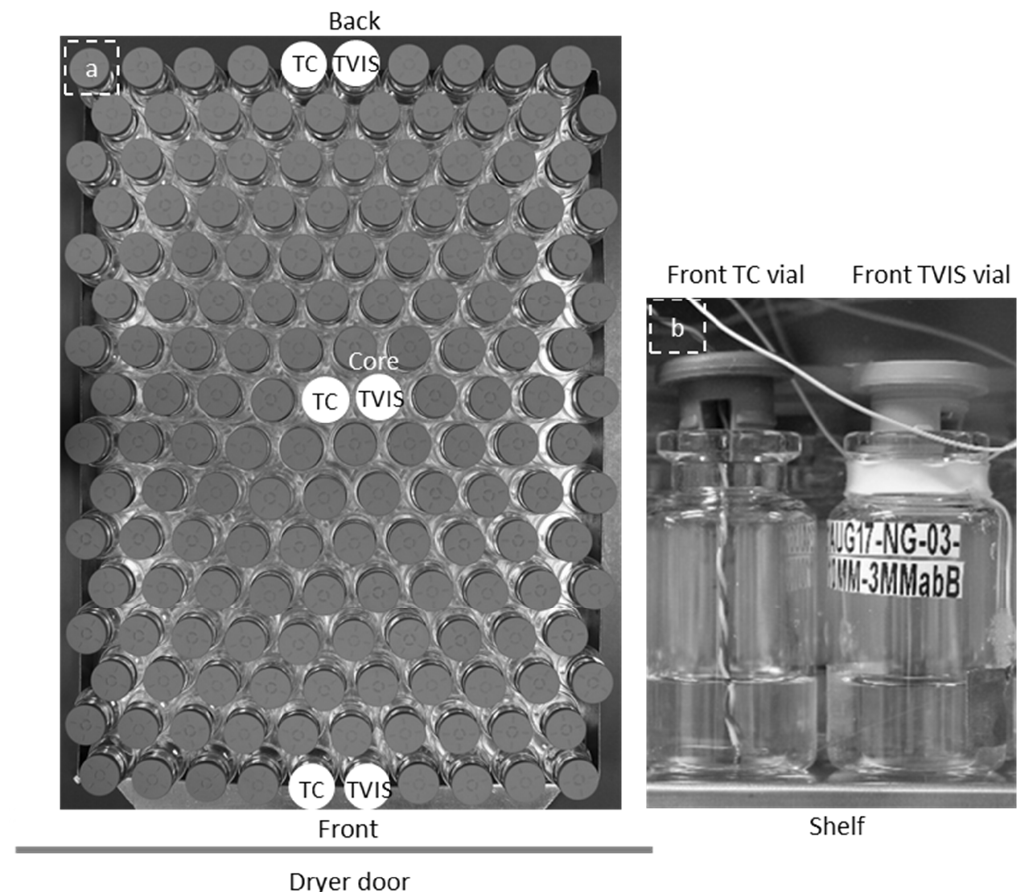
Figure 2. Freeze-drying of double distilled water in a batch of 160 × 10R vials: ( a ) Top view of the vial array showing the position of the TC and TVIS measurement vials; ( b ) the front TVIS vial and the nearest neighbor vial containing a Type T thermocouple with its sensing element in contact with the bottom center of the vial base.